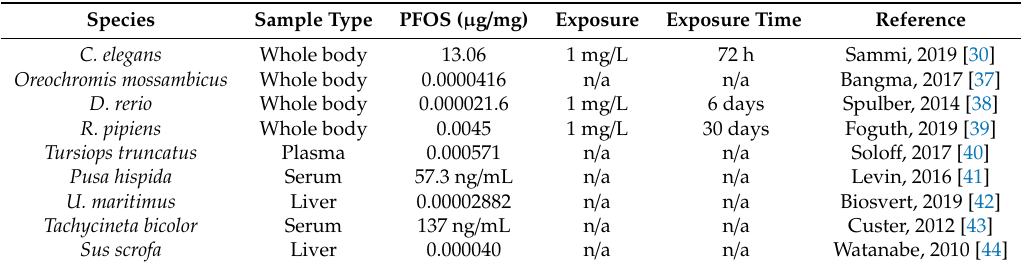
Table 1. Examples of PFOS concentrations in di ff erent sentinel and non-traditional laboratory model